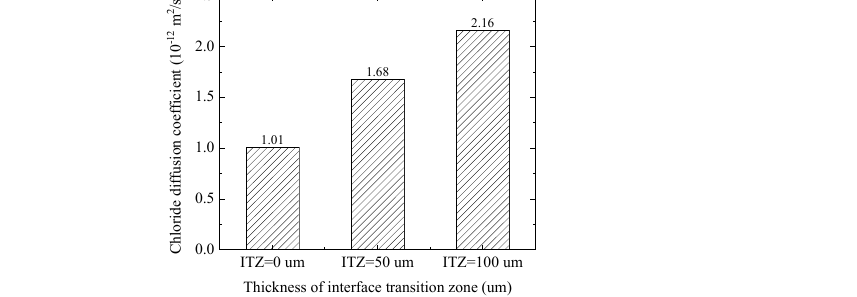
Figure 11. Equivalent chloride diffusion coefficients for different ITZ thicknesses.